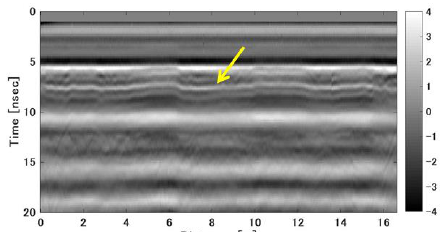
Figure 9. Bscan Image obtained from 200MHz antenna at survey line of